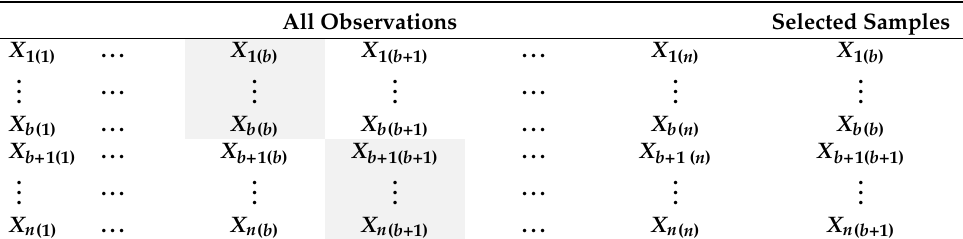
Table 2. Median ranked set sampling scheme with even set size. All Observations Selected